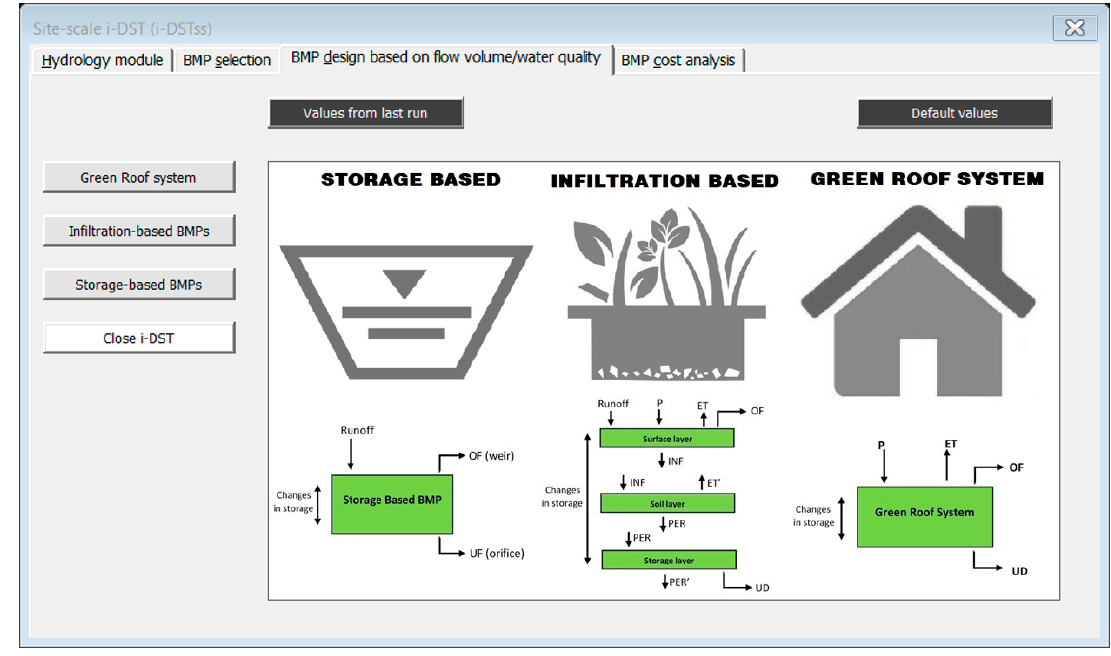
Figure 19. Graphical user interface (GUI) of i-DSTss (BMP sizing module).